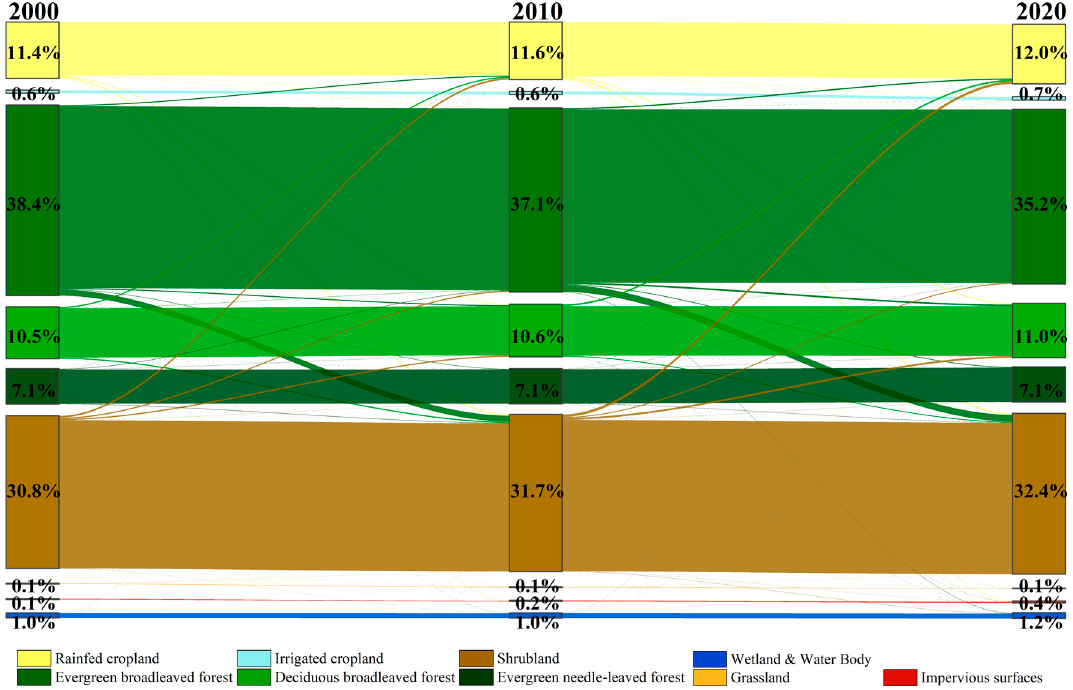
Figure 5. LUC transfer plot of Laos during 2000–2020.